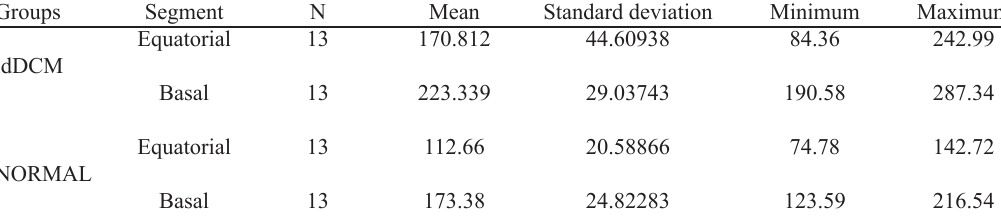
Table 1. Descriptive measures of equatorial and basal perimeter variables in idDCM and NORMAL (mm) right ventricle groups.